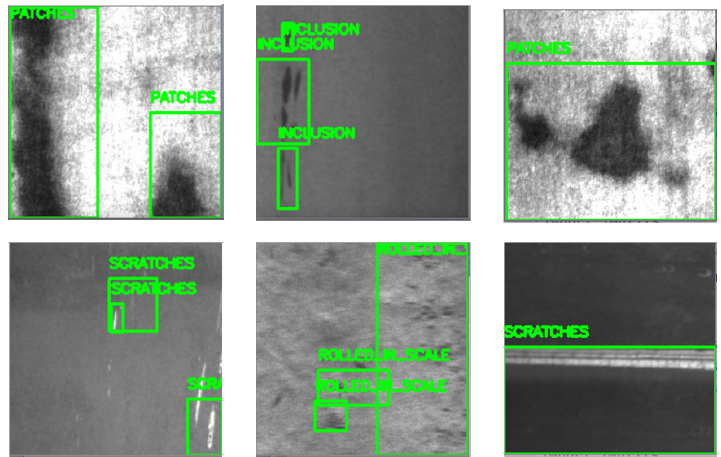
Figure 9. Defect inspection